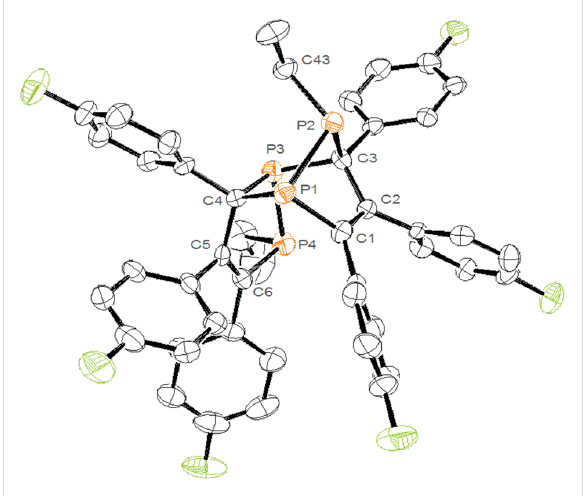
Figure 1: ORTEP view of 2,3,4,4a,5,6-hexa( p -fluorophenyl)-1-ethyl- 1,7,7a-triphospha-4,7-(ethylphosphinidene)indene ( 2e ). Hydrogen atoms are omitted for clarity. Selected bond lengths [Å] and angles [°]: P1–C1 1.850(5); P1– С 4 1.923(6); P1– Р 2 2.213(2); P2– С 43 1.843(5); P2– С 3 1.896(5); C1– С 2 1.360(7); C2– С 3 1.540(7); P3– С 3 1.924(6); P3– С 4 1.902(6); P3–P4 2.193(2); P4– С 6 1.832(5); C5– С 6